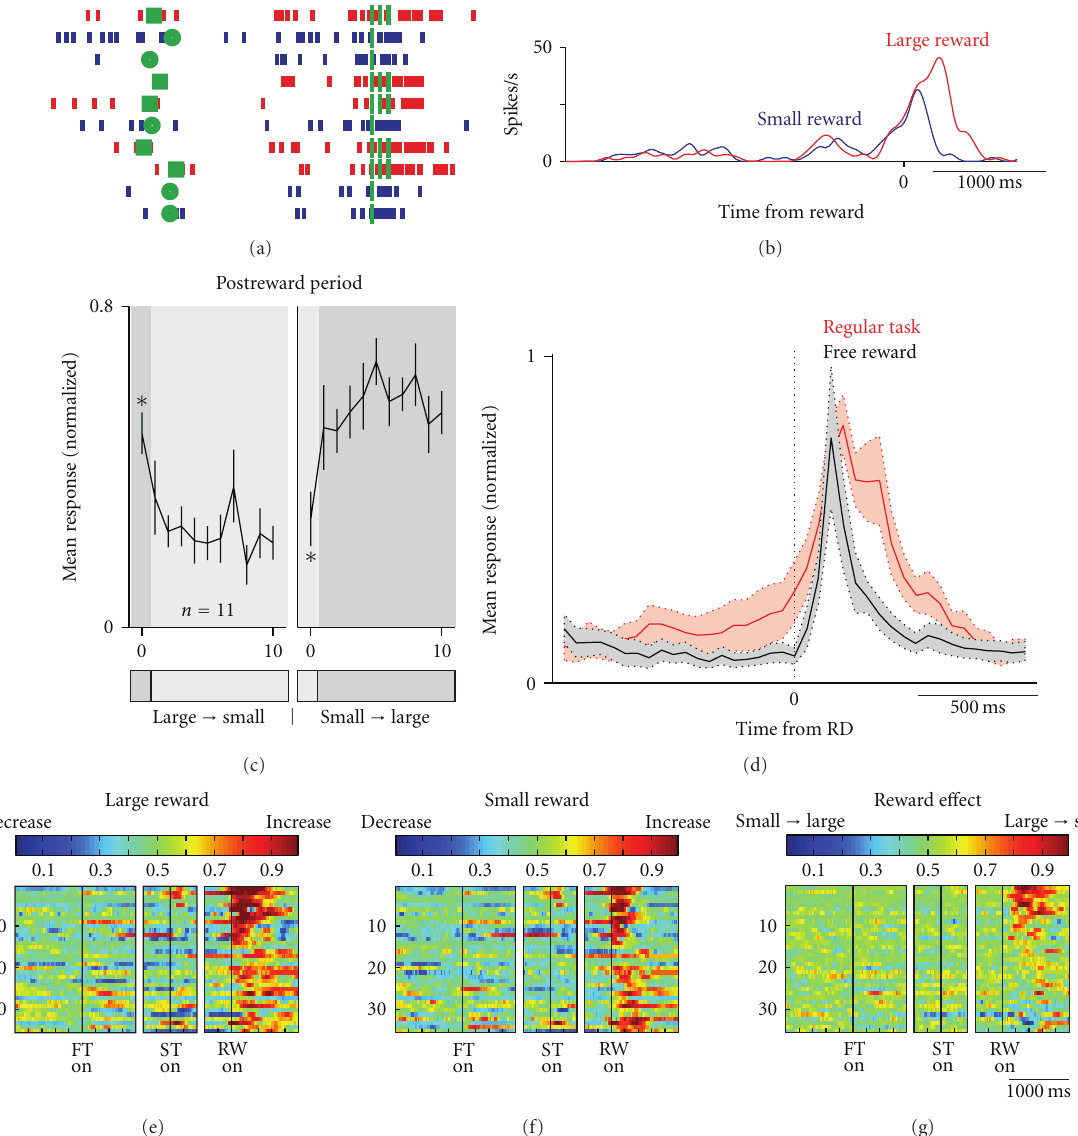
Figure 5: Activity of reward delivery neurons of the PPTN for the saccade task. (a, b) A rastergram and peritask event spike density function for the activity of a representative reward delivery neuron over 10 successive trials, aligned to reward delivery. (c) Responses of the reward delivery neurons to reward delivery of large and small rewards after the reversal of cue-reward contingency. (d) Population response of reward delivery neurons to free (black) and large (red) rewards. The responses represent the average firing rate normalized for the peak responses of the individual neurons ( n = 9). The thick lines indicate the mean normalized activity, and the light-shaded areas are ± 1 SEM. (e–g) The activity of each reward-responsive neuron is presented as a row of pixels ( n = 35). (e, f) Changes in the neuronal firing rate from baseline are compared in the large- (e) and small- (f) reward trials. (g) Changes in reward-dependent modulation. In these 3 panels (e–g), the neurons have been sorted in order of their ROC values for the reward e ff ect during the postreward delivery period. FTon: fixation target onset; STon: saccade target onset; RWon: reward onset. (Modified from